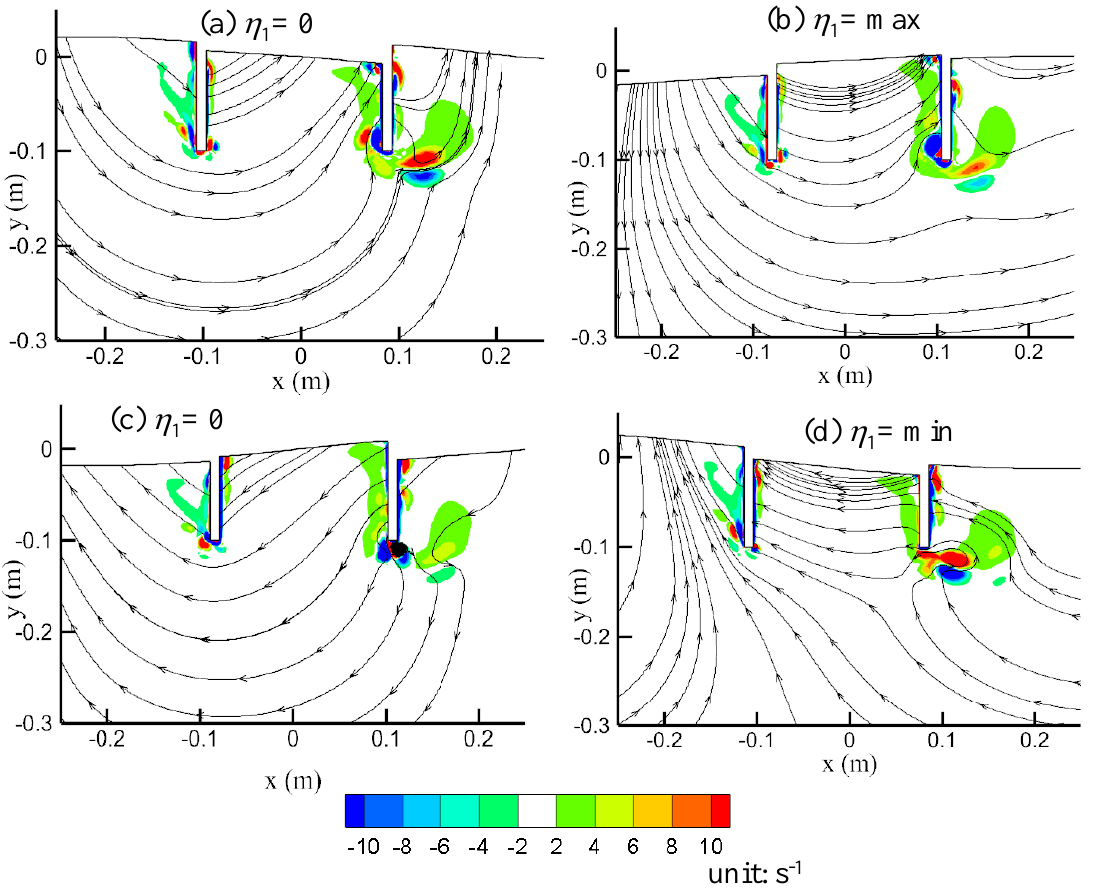
Figure 9. Flow near the OWC represented by streamlines and vorticity contours at horizontal motion, m = 2, B/L = 0.159.